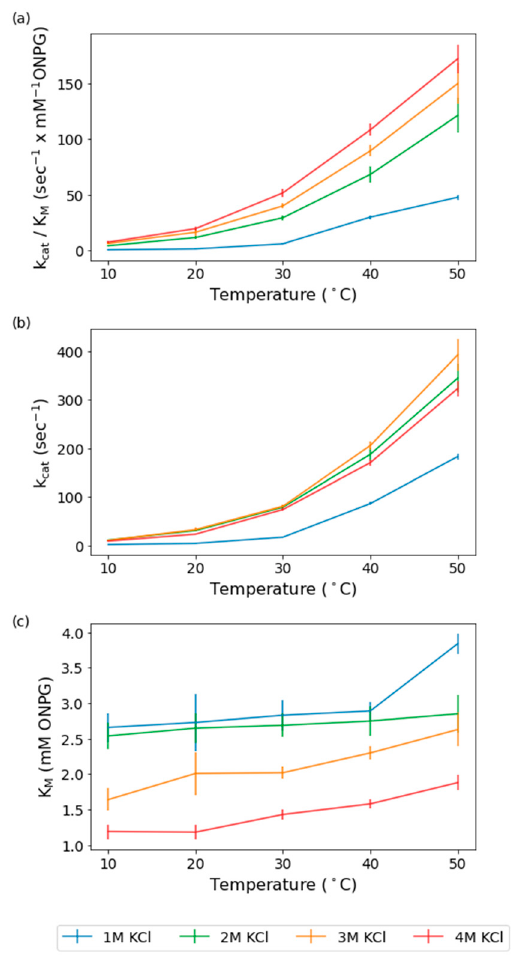
Figure 1. Calculated kinetic constants of wild-type for 1–4 M KCl and 10–50 °C. ( a ). Plots of the catalytic efficiency ( k cat / K m , s − 1 × mM ONPG − 1 ) for the wild-type at 1M KCl (blue), 2M KCl (green), 3M KCl (yellow), and 4M KCl (red) are shown over the temperature range of 10–50 °C on the x -axis, with SEs shown as error bars. ( b ). Plots of the catalytic rate constant ( k cat , s − 1 ) for the wild-type at 1M KCl, 2M KCl, 3M KCl, and 4M KCl are shown over the temperature range of 10–50 °C on the x -axis, with SEs shown as error bars. ( c ). Plots of the Michaelis constant ( K m , mM ONPG) for the wild-type at 1M KCl, 2M KCl, 3M KCl, and 4M KCl are shown over the temperature range of 10–50 °C on the x -axis, with SEs shown as error bars ( n = 3).